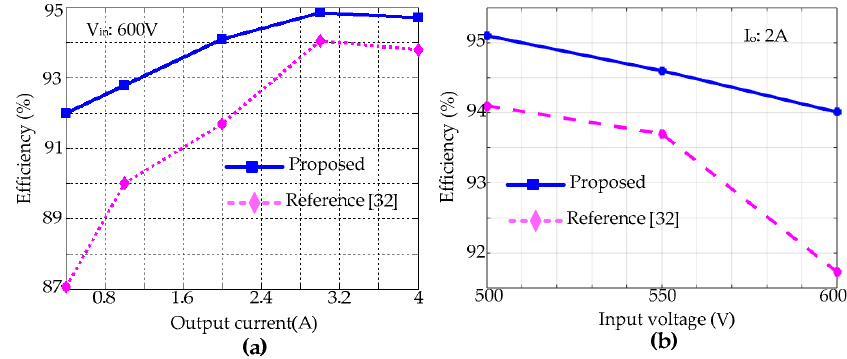
Figure 11. Efficiency comparison: ( a ) Efficiency with constant V in and variable I o ; ( b ) Efficiency with constant I o and variable V in .